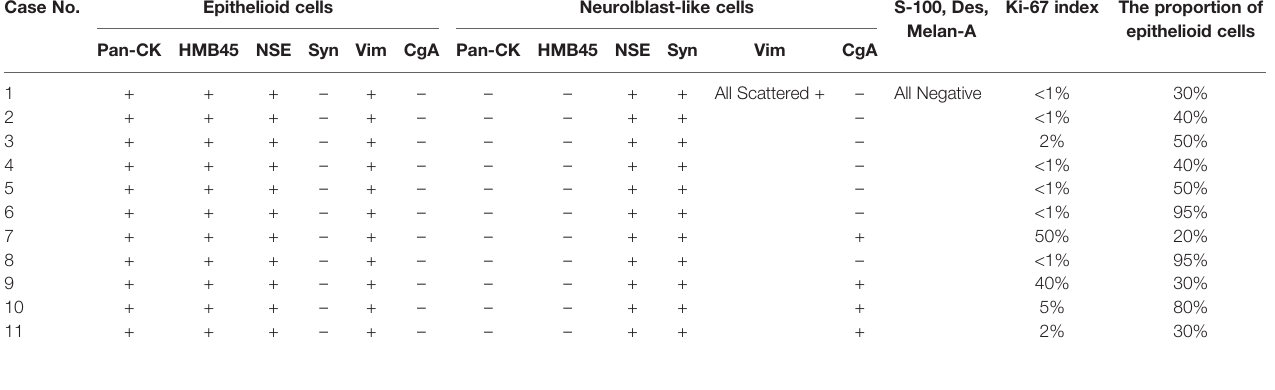
TABLE 3 | The immunohistochemical pro fi le and proportion of epithelioid cells of MNTI. Case